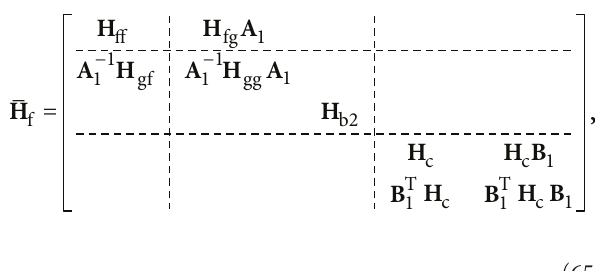
Figure 13: Angle relation between coordinates g and 0.